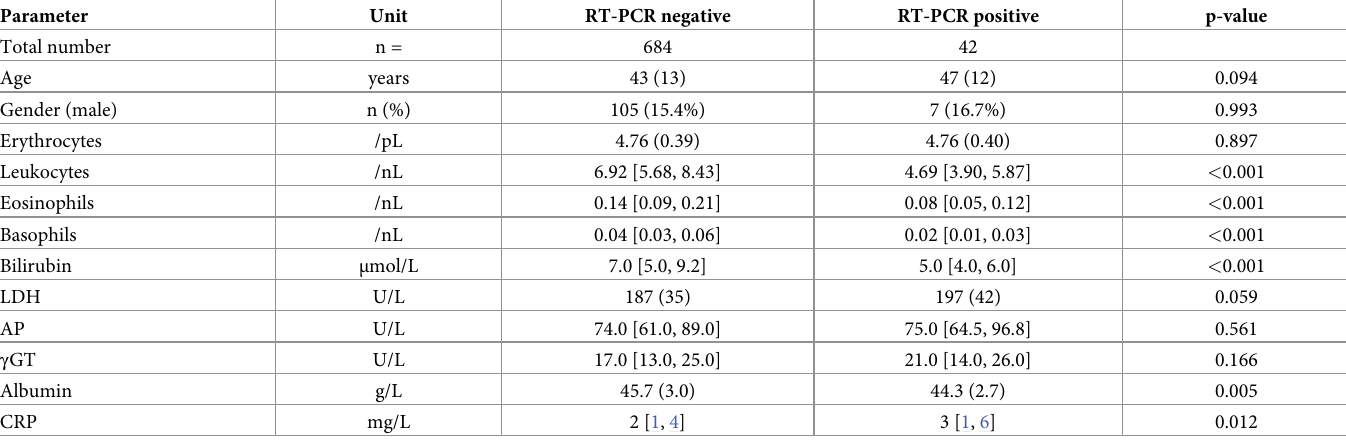
Table 1. Descriptive statistics. Shown are the laboratory tests required for the CoLab-score and their mean/median results split by RT-PCR test result. For results with normal distributions, the mean value and standard deviation (in round brackets) are shown. For results that have skewed or heavy tailed distributions, the median value and the interquartile range is shown [in squared brackets]. The p-value corresponds to a t-test in cases of a normal distribution, a Man-Whitney U-test for non-normally distributed variables and a Fisher exact test for categorical variables.